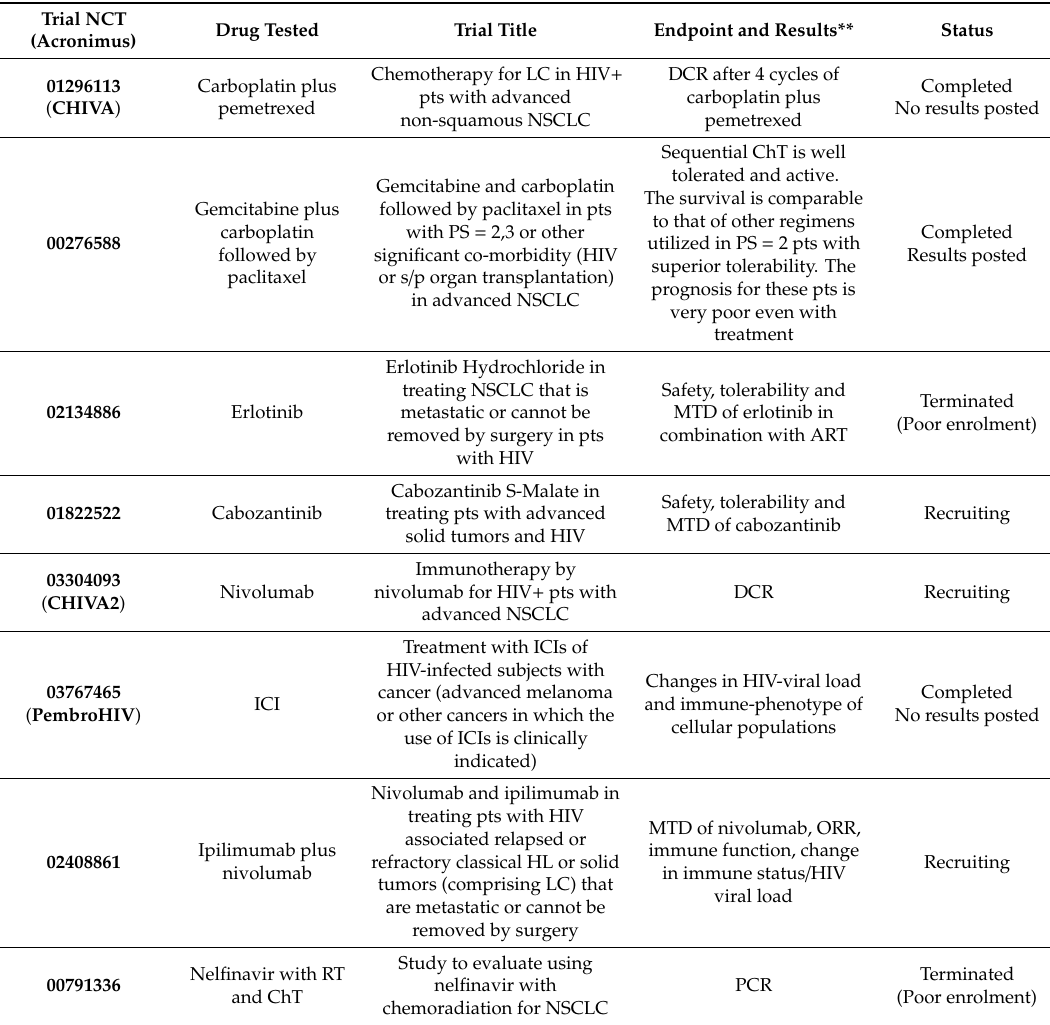
Table 2. Clinical trials investigating HIV and lung cancer. The table listed clinical studies investigating the impact of HIV infection on risk factors, epidemiology, features of LC, as well as implication for LC treatments. Information of active / closed clinical trials has been derived from https: // clinicaltrials.gov. The three trials marked in light blue enroll / enrolled people with cancer HIV-uninfected or PLWH without cancer, but anyhow the contribute from these trials might be important to acquire more information about DDIs. **when available. ART: antiretroviral therapy; ChT: chemotherapy; DCR: disease control rate; HL: Hodgkin Lymphoma; ICIs: Immunological Checkpoint Inhibitors; LC: lung cancer; MTD: maximum tolerated dose; NGS: next-generation sequencing; NSCLC: non-small cell